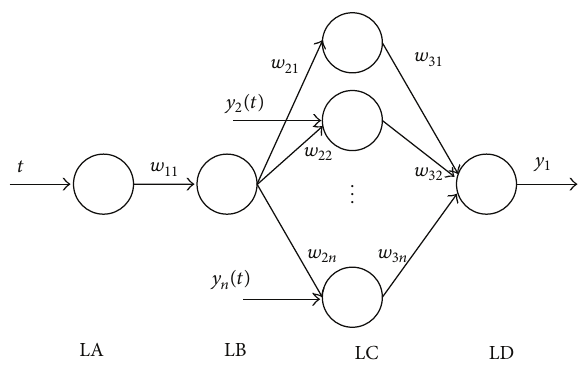
Figure 1: Gray neural network structure topology.